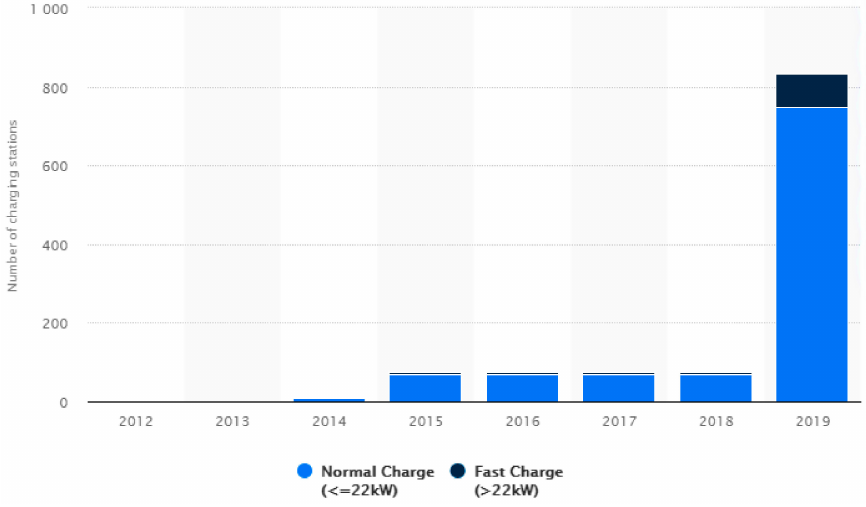
Figure 4. Number of electric vehicle charging stations in Turkey, by type